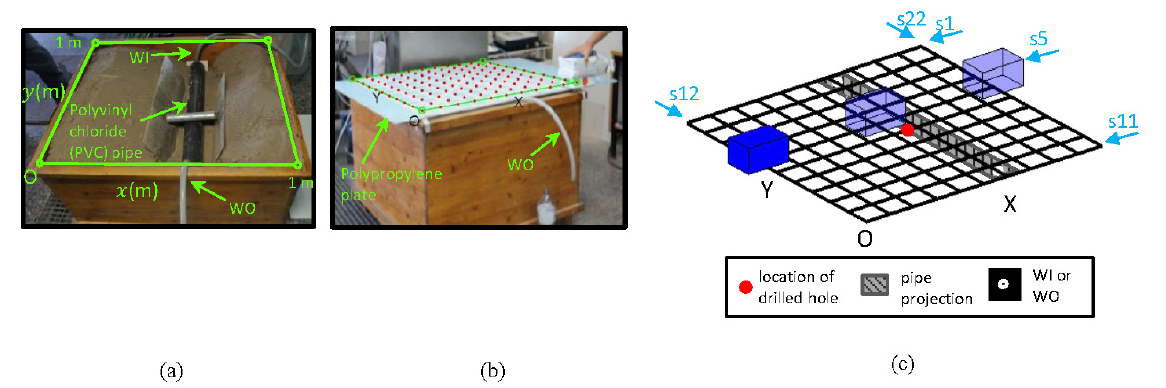
Figure 1. Laboratory layout. WI, water input; WO, water output.